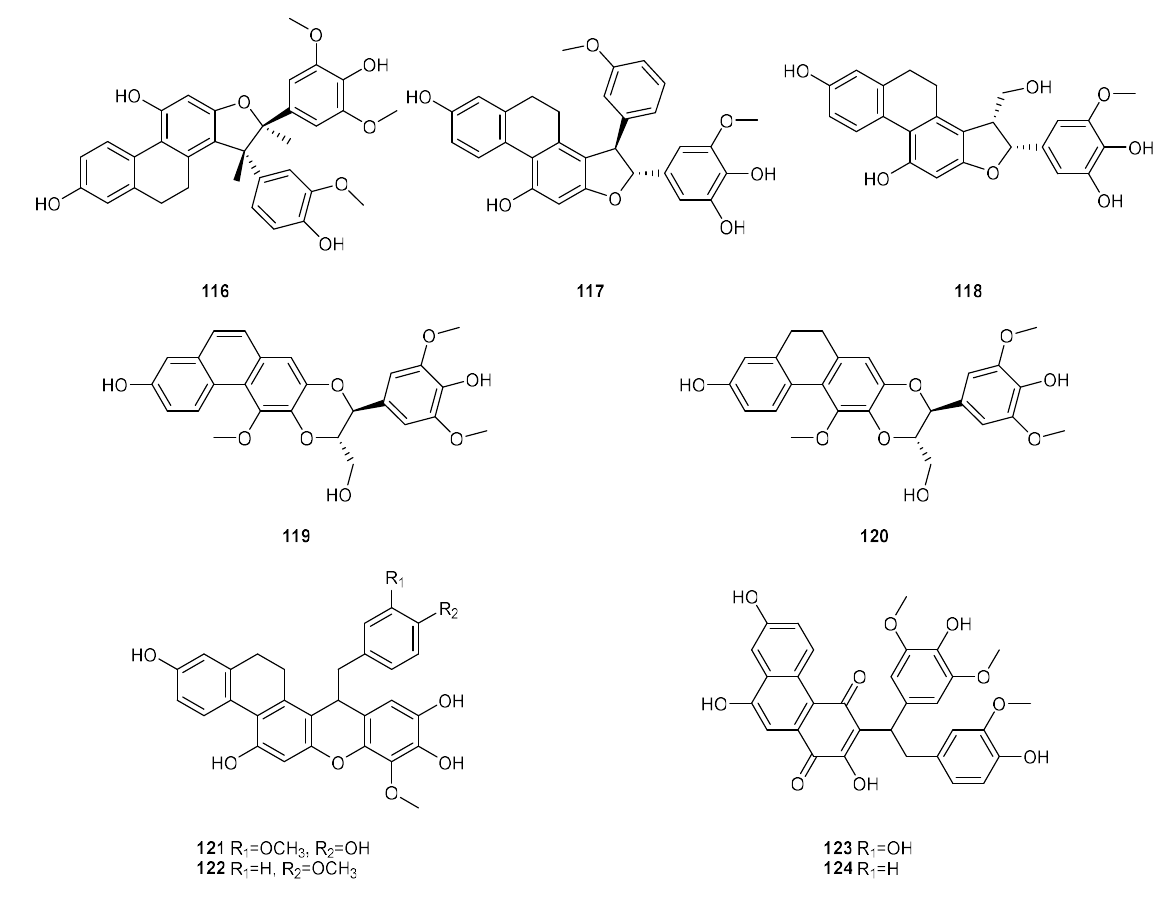
Figure 1. The structures of phenanthrene compounds ( 1–124